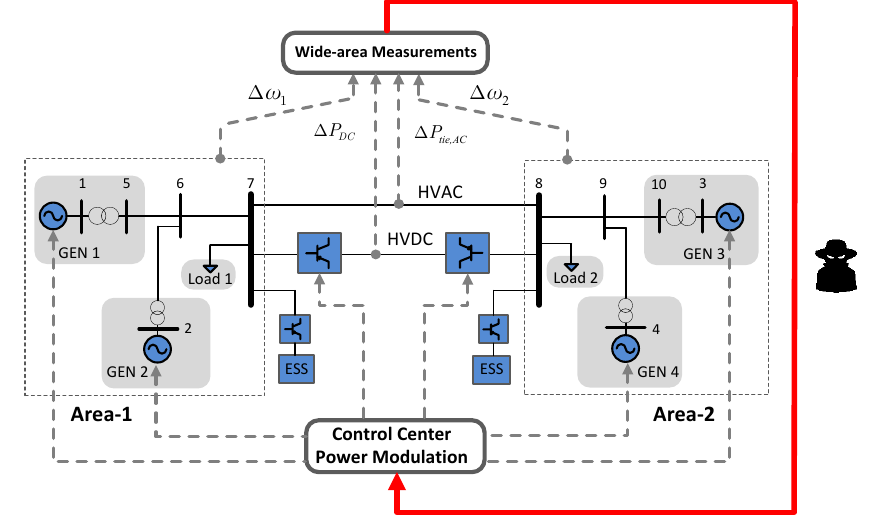
Figure 1. The block diagram of the test system. The communication channels (the red line) for the transmission of wide-area measurements are very vulnerable, and therefore the cyber attacks of Denial of Service (DoS) and false data injection (FDI) in this article are mainly on the measurements side. To be noted, we assume that the channel for control signals is equipped with advanced encryption techniques and thus not